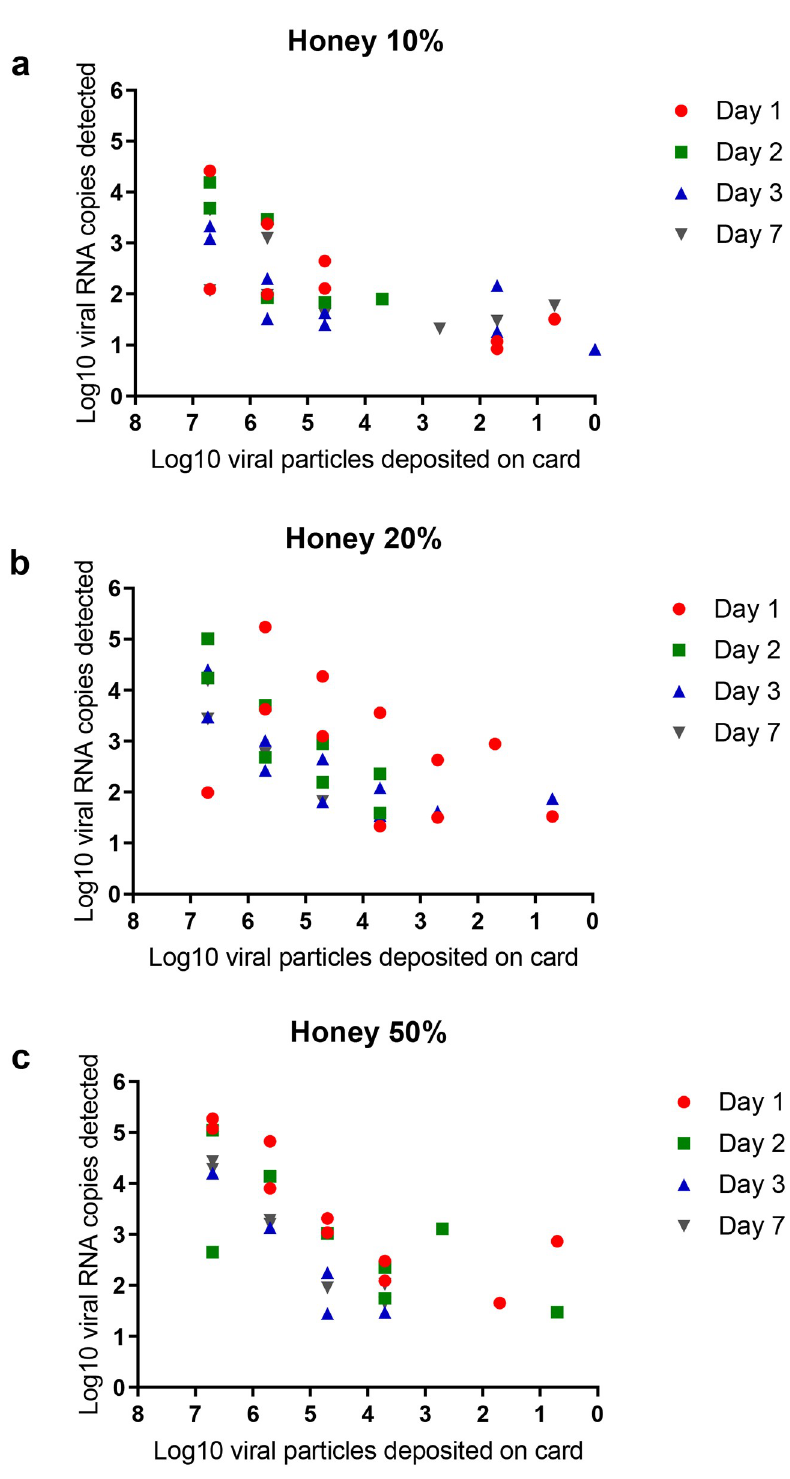
Fig 1. Viral RNA copies detected on 0.9 cm 2 spotted with different quantities of CHIKV particles (5 to 5x10 6 pfu) and impregnated with honey solutions (10%, 20%, 50%), examined at day 1, 2, 3 and 7. Different quantities of viral particles were deposited on 0.9 cm 2 cards imbibed with honey solutions. After 1, 2, 3 and 7 days of incubation at 28˚C, cards were immersed in 500 μ L of FBS (fetal bovine serum) for 1h at +4˚C. Samples were processed for RNA extraction and qRT-PCR. Two replicates were performed. Each dot represents one card; detailed information in S2 Table.